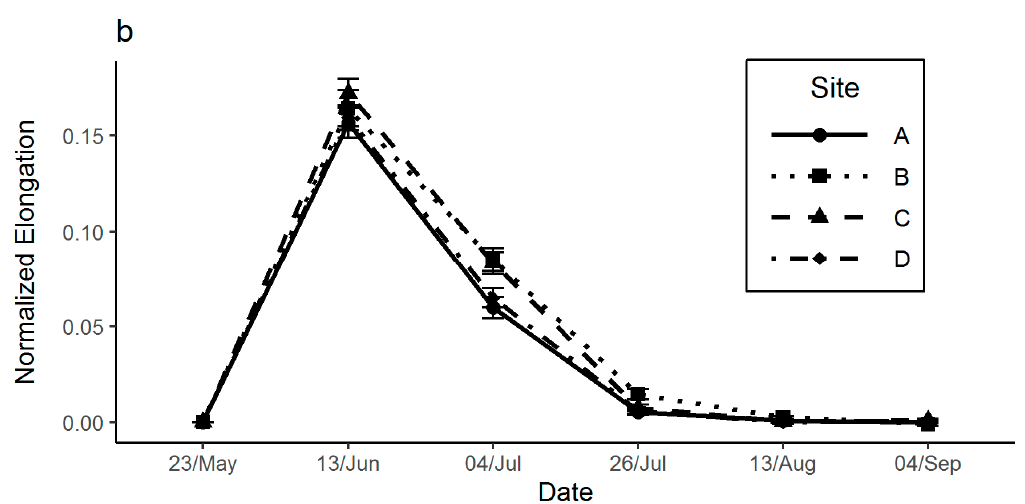
Figure 3. Normalized values of diameter increment ( a ) and shoot elongation ( b ) measured throughout the growing season of 2018. Notice the peaks-and-trough pattern in ( a ), which points to a decrease in the diameter increment during the season. Error bars represent the standard error.